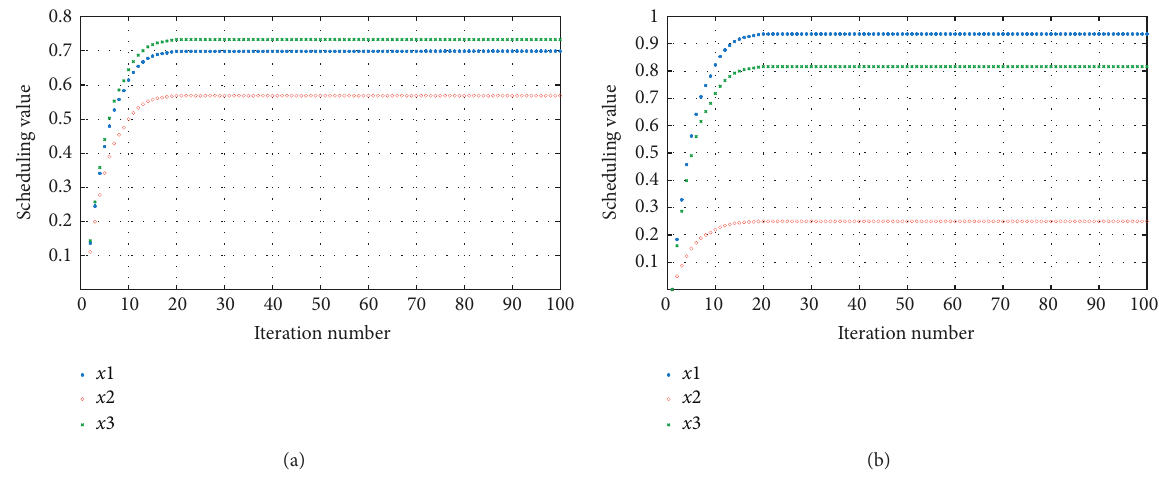
Figure 7: Iteration calculation results of state noncooperative game. (a) 0.5s; (b) 1 s.